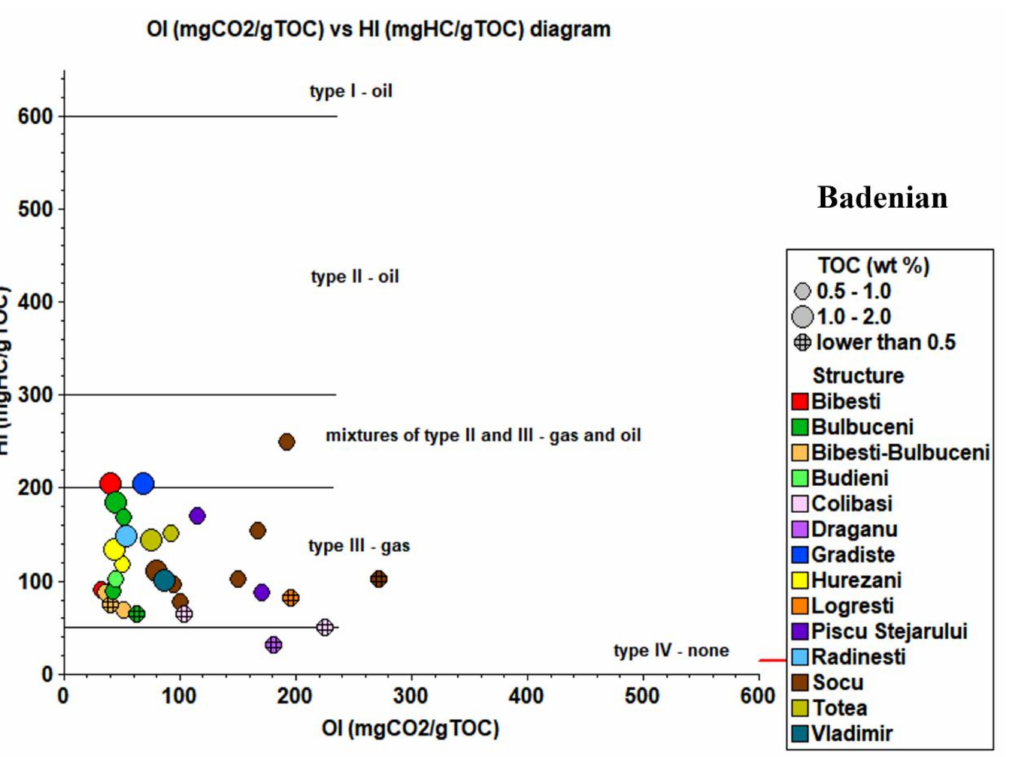
Figure 13. Oxygen Index (OI) (mg CO 2 /g TOC) vs. Hydrogen Index (HI) (mg HC/g TOC), in a modified Pseudo Van Krevelen diagram, showing the kerogen types of Upper Badenian samples from the Getic